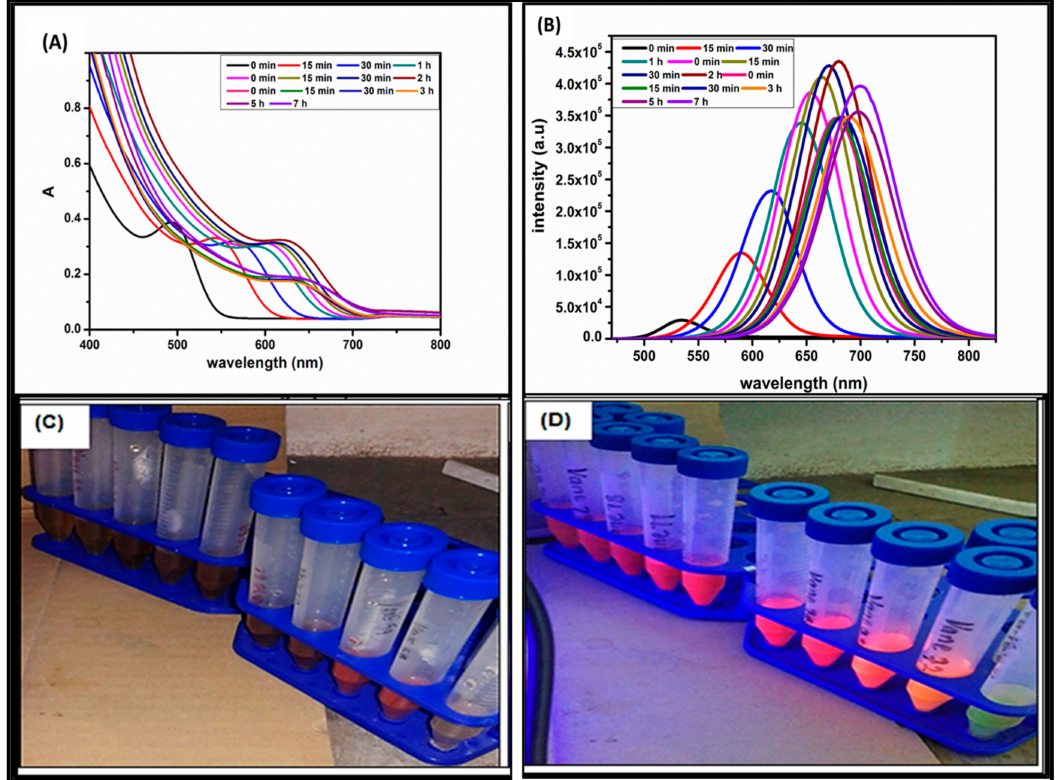
Figure 1. ( A ) UV-Vis absorption. ( B ) photoluminescence. ( C ) spectra of MPA-capped CdTe/CdSe/ZnSe core-multishell quantum dots at different growth stages and reaction time. Digital images of the as-synthesized CdTe/CdSe/ZnSe QDs (at different reaction time) under UV-lamp at an excitation wavelength of 250 nm. ( D ) 350